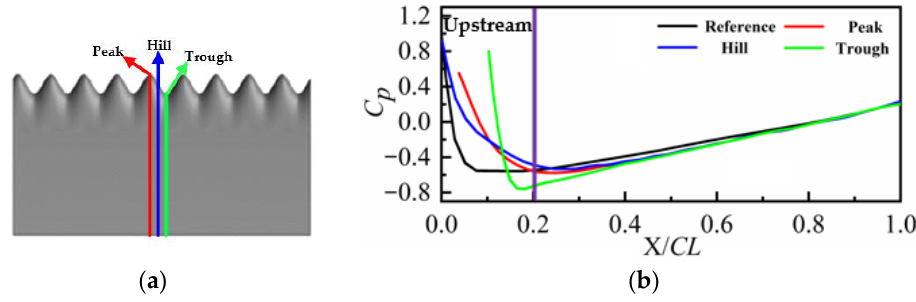
Figure 12. Comparison of the time-averaged pressure coefficient. ( a ) Chord position; ( b ) Time-averaged pressure coefficient.